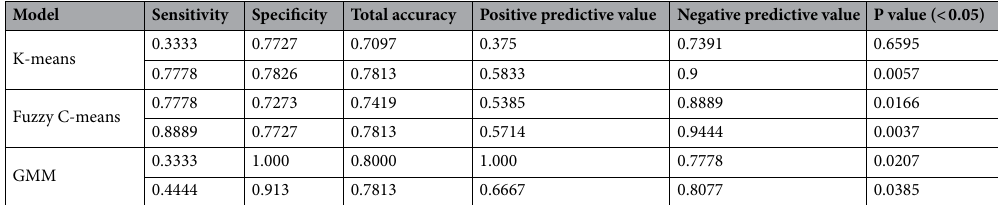
Table 1. Summary of cluster model performances in relation to 5-year patient survival, expressed in the form of sensitivity, specificity, total accuracy, positive predictive value, negative predictive value, and p-values based on the two-tailed Fisher’s exact test. The positive predictive value represents the population that did not survive and the negative predictive value for those that did survive. The top row for each model indicates results for the majority-vote approach performed on sample sizes of n = 31 for K-means, Fuzzy C-means, and n = 30 for GMM; the bottom row summarizes the performance of the features-averaged approach n = 32 for all three clustering models. Important to note that the respective tests are assuming the ideal groupings where Cluster 1 represents patients which survived, and Cluster 2 contains patients which do not. The results presented compare how well the findings reflect this assumption (for details, see text).